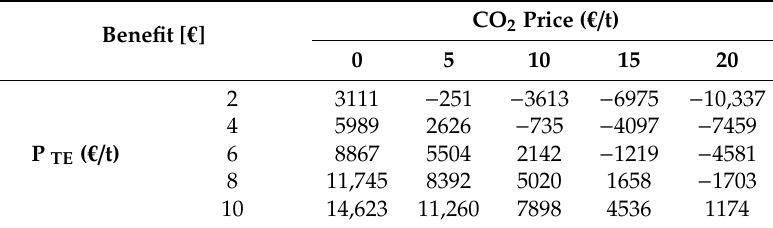
Table 10. Sensitivity analysis of the CO 2 and thermal energy